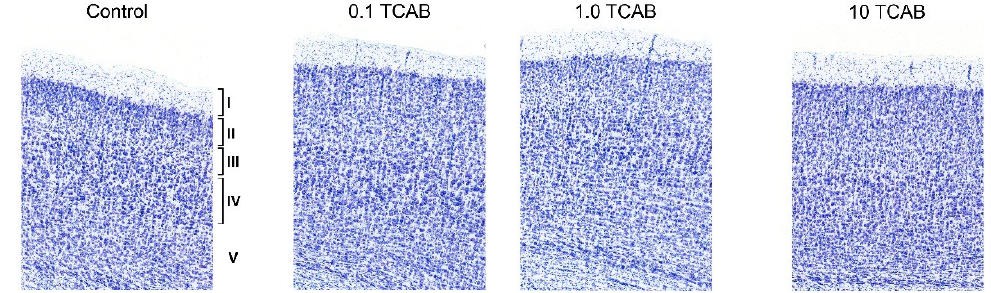
Figure 7. Representative Nissl staining of the cortex at PND21. Cortical layers I–III, and IV were identified in the controls and 0.1 mg/kg/day TCAB dosed animals while layer V was more diffuse. The 1.0 mg/kg/day group showed a less-well compacted layer IV with diffusion into layer III. In the 10 mg/kg/day group, the distinction between layers II and